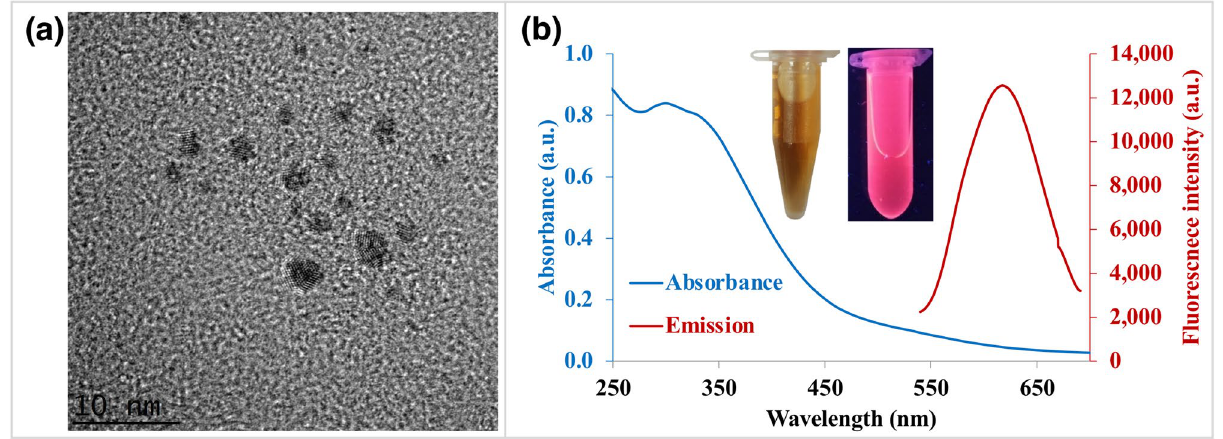
Figure 1. Characterization of BSA/AuNCs. ( a ) HRTEM image of the diluted fluorescent BSA/AuNCs. ( b ) UV– Vis absorption (blue line) and fluorescence emission spectra (red line) of the as-prepared BSA/AuNCs with λ ex at 365 nm. Inset: optical photographs of the BSA/AuNCs under visible (left) and UV light